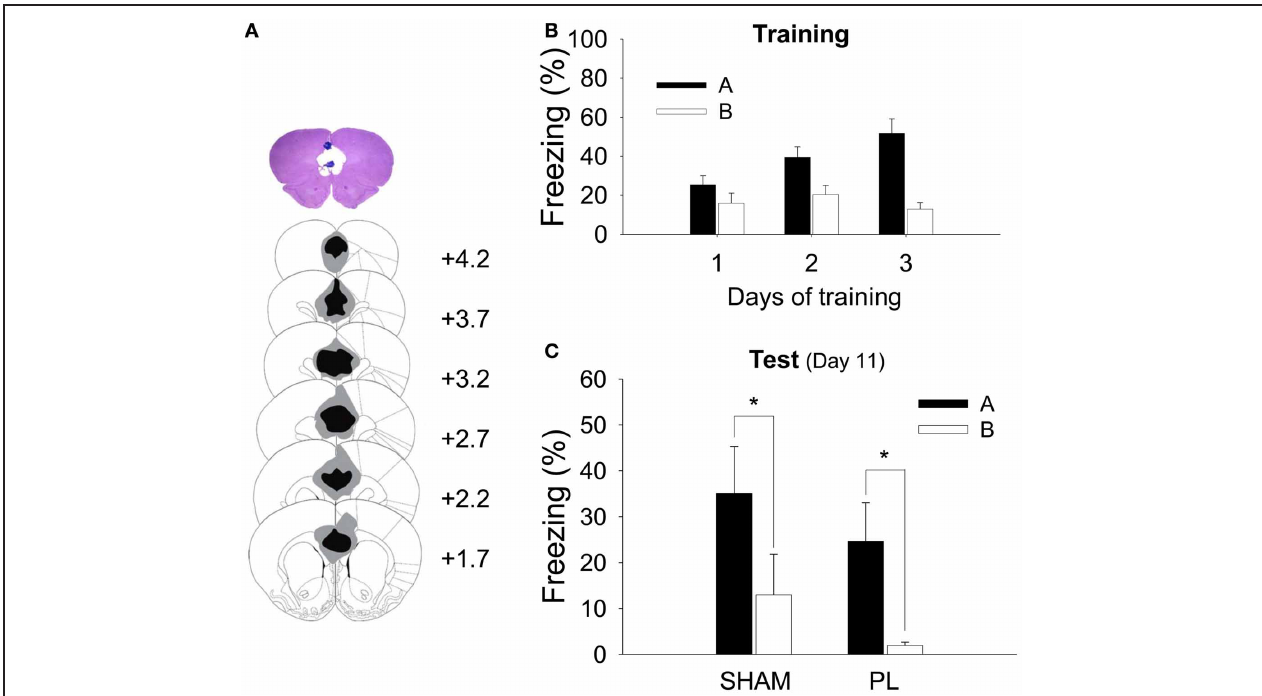
sections (Paxinos and Watson, 1998). (B) During training, all animals gradually acquired fear responses to Context A but not to Context B. (C) After the surgery, both SHAM and PL lesion groups continued to show differential response to the two contexts as indicated by a higher level of freezing to Context A than that to Context B. ∗ denotes p < 0 .